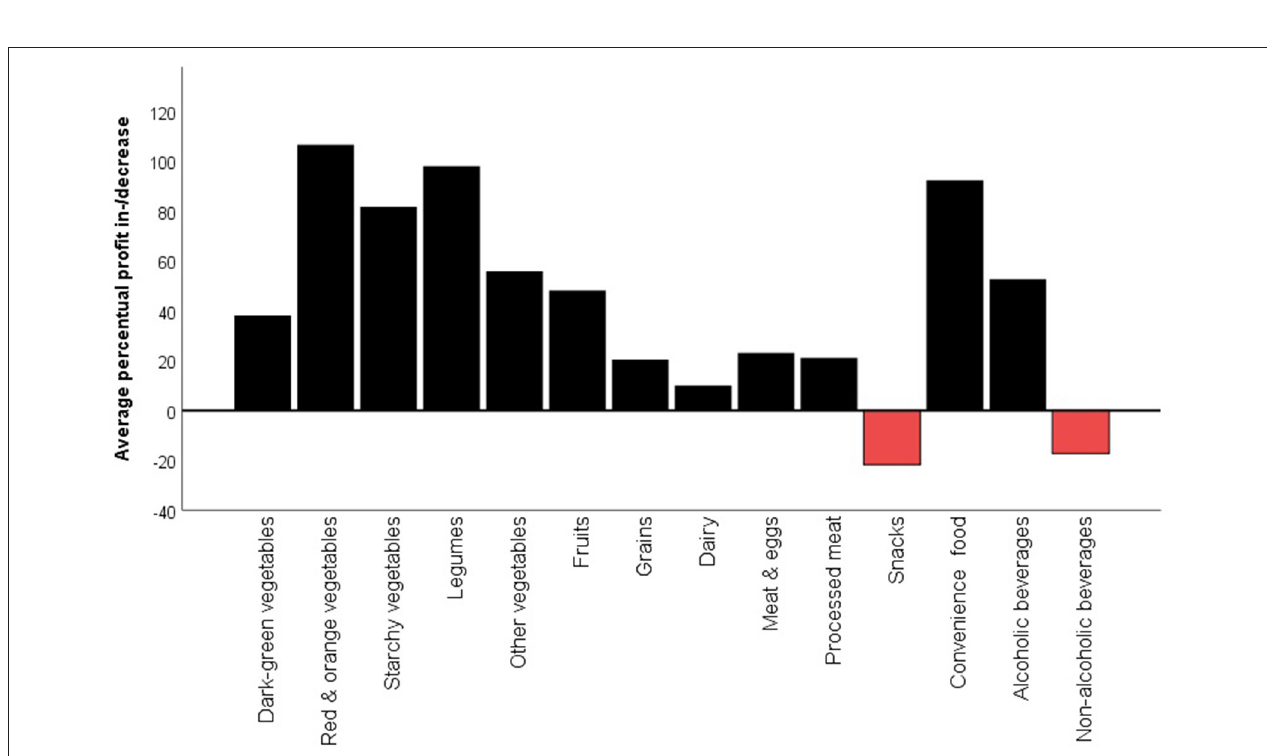
FIGURE 4 | Percent changes in average monthly grocery store profits per food category, comparing March and April 2019 and March and April 2020 ( p = 0.02) in nominal US$ values. 3.2% Consumer Food Price Index increase between April 2019 and April 2020 (US Bureau of Labor Statistics, 2021).